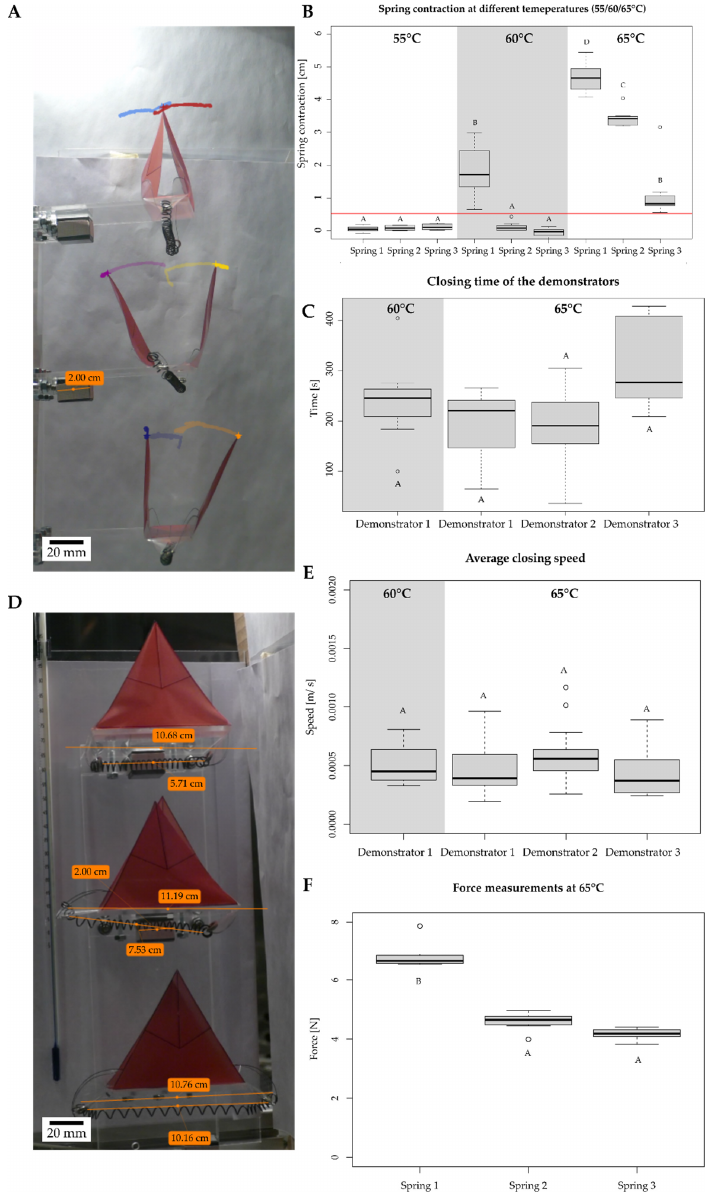
Figure 6. Kinematic motion analysis of the thermally driven VFf. Each demonstrator was actuated by a thermo-responsive SMA spring, which contracted and thus performed a closing motion when a critical temperature was reached. The tested demonstrators were placed in a climate chamber at three different temperatures. Videos were recorded from two perspectives ( A , D ), and the closing movement was further analyzed via motion tracking. Spring length was determined before and after the heating cycle ( D ), and the difference in length was calculated for complete closure. In ( D ), the upper orange line represents the demonstrator length and lower orange line the spring length before actuation. All boxplots above the red line indicate full closure ( B ). Each boxplot represents seven measurements. Different letters represent significant differences from other results with p -values below 0.05. Closing times ( C ) and speeds ( E ) were measured with the help of the motion paths (colored tracks of lobe tips). Closing times ranged from 36 s to 429 s with an average of 234.7 s, whereas average closing speeds ranged from 0.19 × 10 − 3 m/s up to 1.1 × 10 − 3 m/s. Each boxplot represents 14 measurements. In order to determine the force that was generated by the springs at closing temperature (65 ◦ C), they were placed in the thermal chamber of the testing machine, and the output force was measured ( F